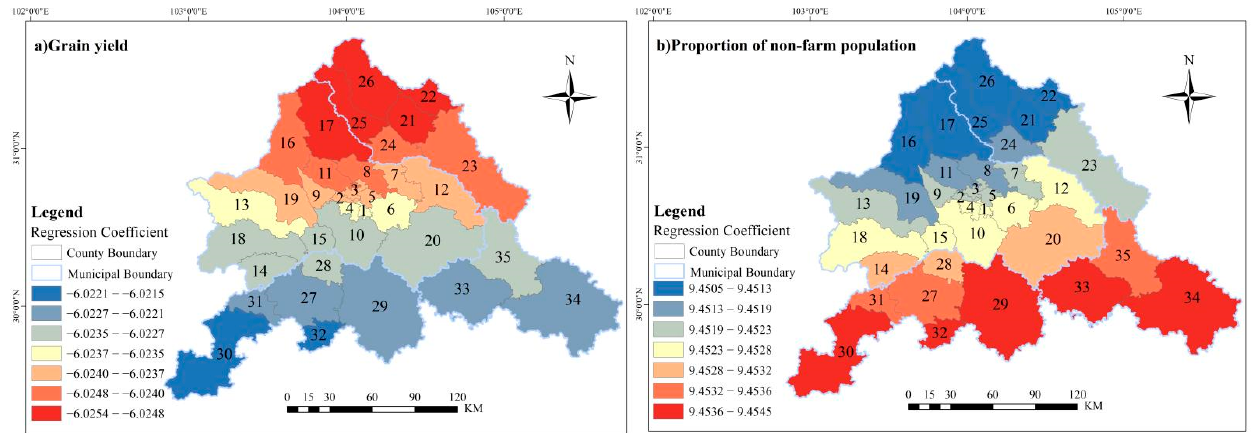
Figure 6. Dominant factors from 2010 to 2018: ( a ) Regression coefficients of grain yield (2010–2015); ( b ) Regression coefficient of the proportion of the non-farm population (2015–2018).